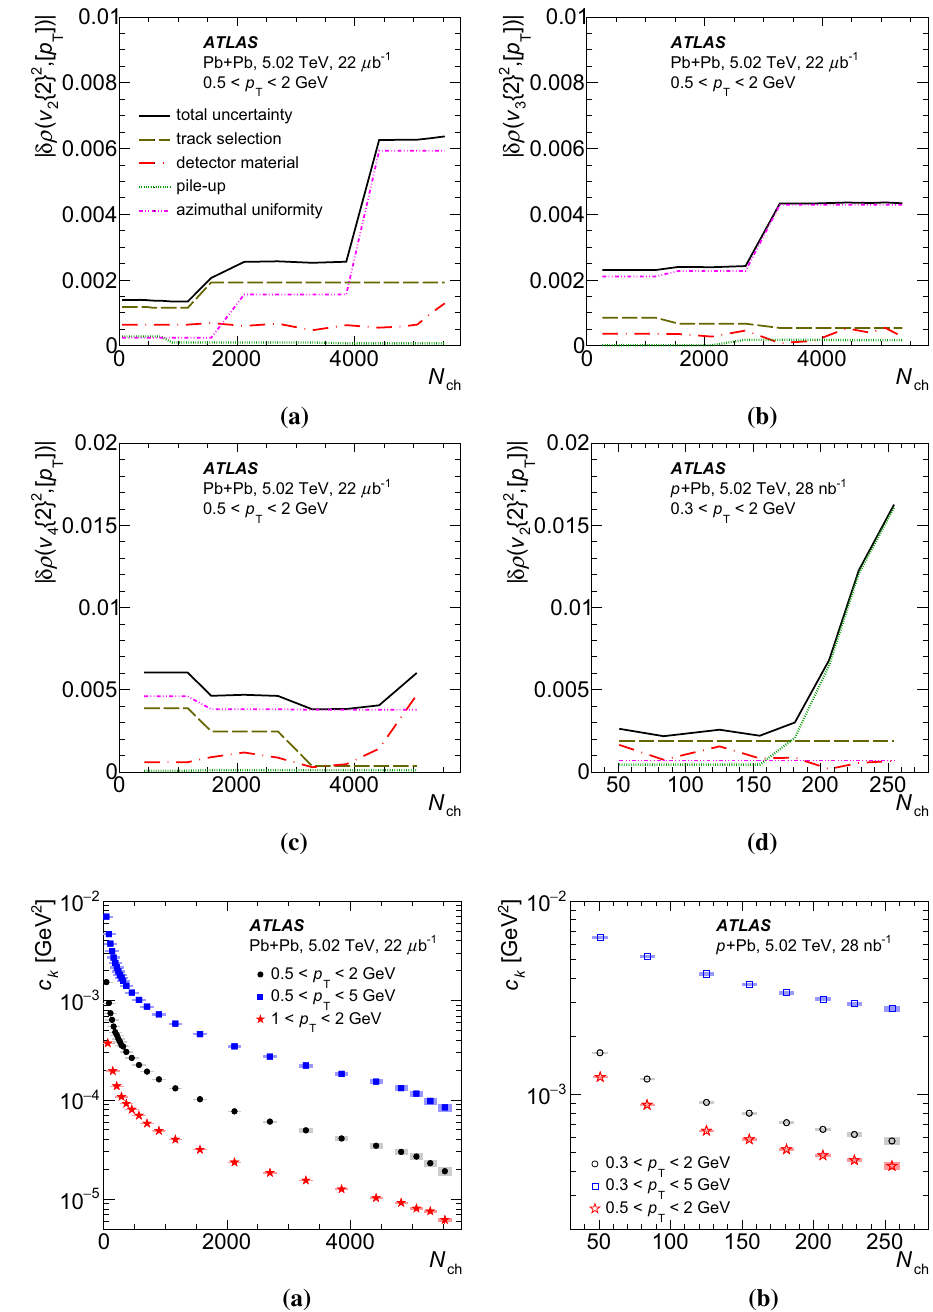
Fig. 1 The systematic uncertainty of ρ(v n { 2 } 2 , [ p T ] ) as a function of N ch measured with tracks from main p T intervals for each collision system for the a second, b third, and c fourth harmonics in Pb+Pb collisions, and for d ρ(v { 2 } 2 , [ p ] ) in p +Pb 2 T collisions. The total uncertainty is also shown